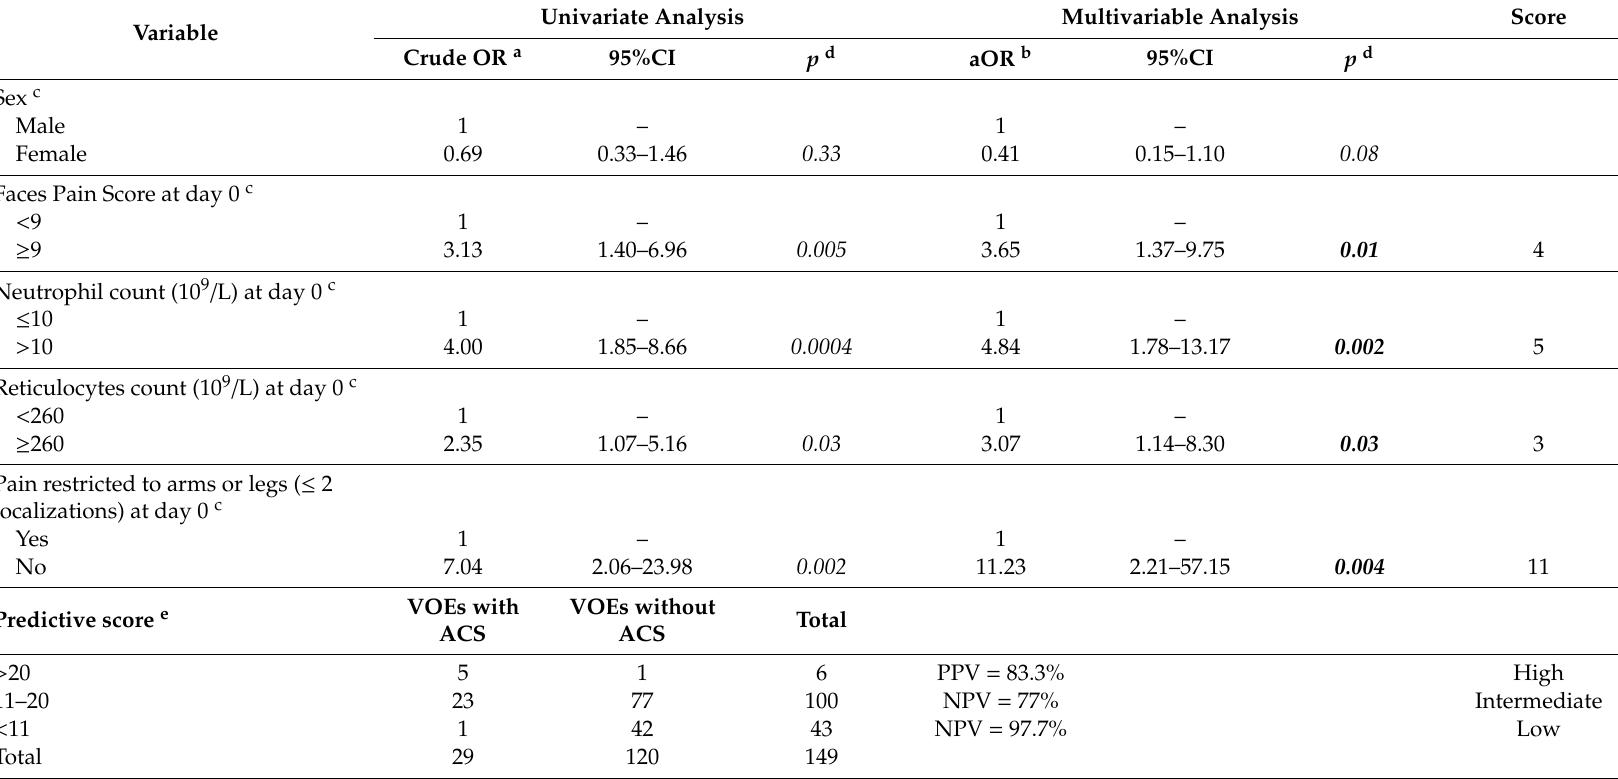
Table 3. Univariate and multivariable analyses and predictive model for acute ACS in children with sickle cell disease and hospitalized for a VOE. Univariate Analysis Multivariable Analysis Score Variable Crude OR